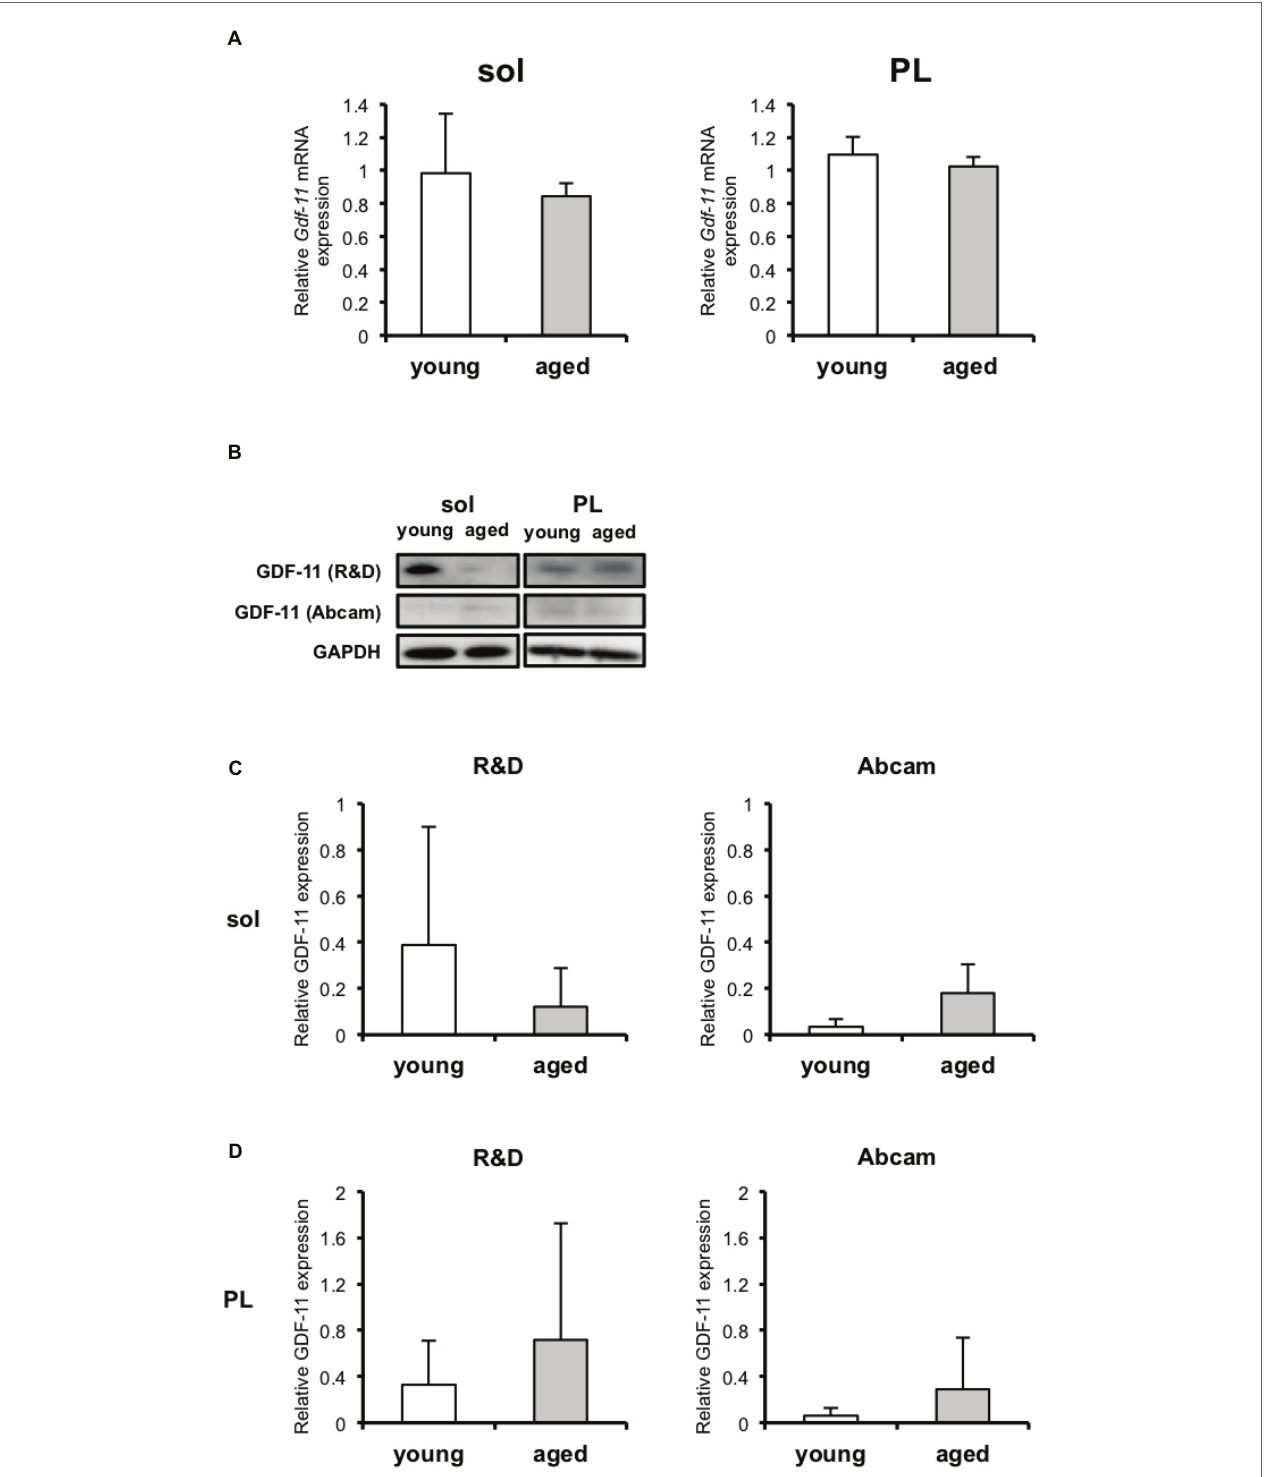
FIGURE 3 | GDF11 expression in skeletal muscles of young and aged mice. (A) Gdf11 mRNA levels in soleus (sol) and plantaris (PL) of young ( n = 6) and aged ( n = 5) mice. (B) GDF11 protein detected by western blotting using two different antibodies purchased from R&D Systems and Abcam. (C) Quantitative data for GDF11 protein levels in soleus and plantaris of young ( n = 6) and aged ( n = 4) mice, detected with the R&D Systems anti-GDF11 antibody. (D) Quantitative data for GDF11 protein levels in soleus and plantaris muscles of young ( n = 6) and aged ( n = 5) mice detected with the Abcam anti-GDF11 antibody. The changes in GDF11 expression with aging at both the mRNA and protein levels were not statistically significant. Data are presented as means ±